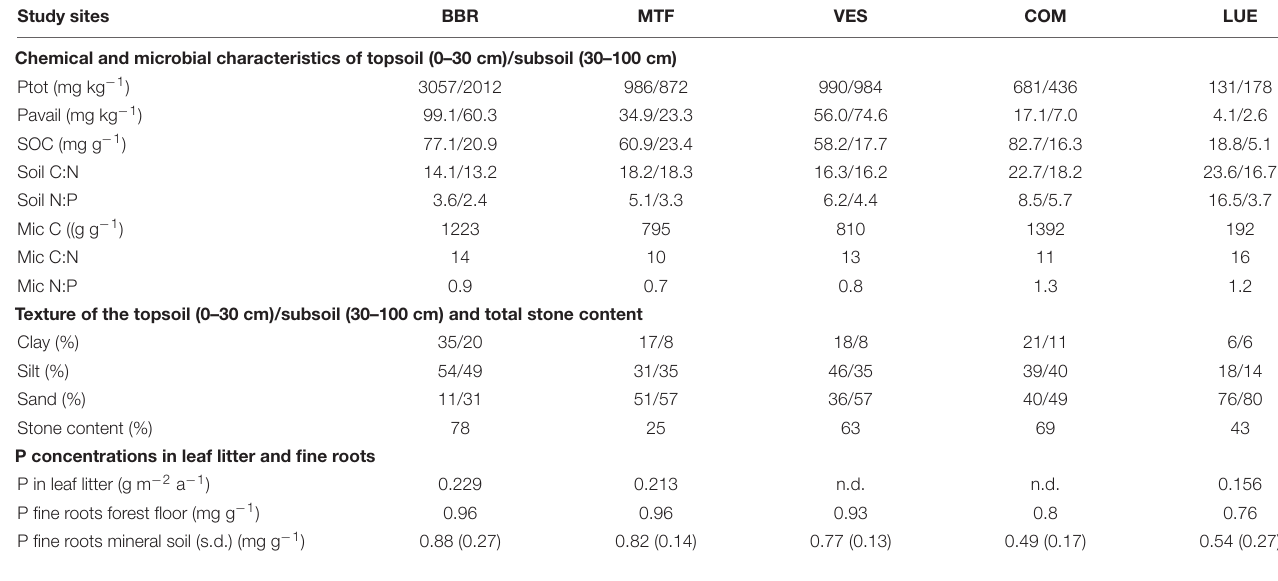
TABLE 1 | Site characteristics of the study sites Bad Brückenau (BBR), Mitterfels (MTF), Vessertal (VES), Conventwald (COM), and Lüss (LUE), reproduced from data in Lang et al. (2017). Study